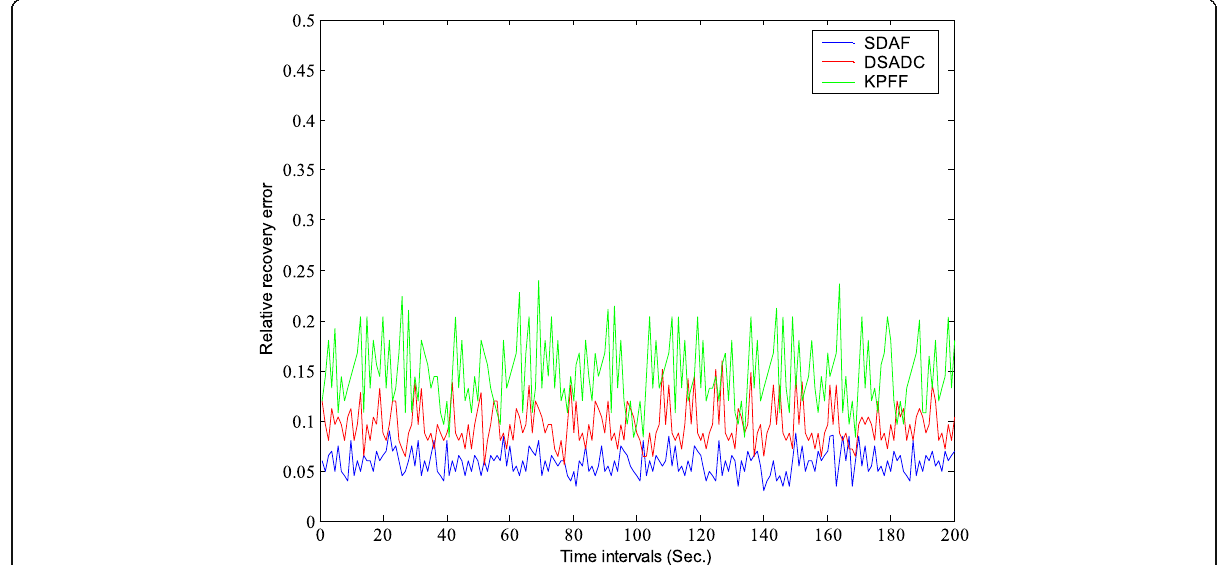
Fig. 4 RRE with outlier probability (5%). Recovery accuracy is a normally used metric to evaluate the quality of data aggregation